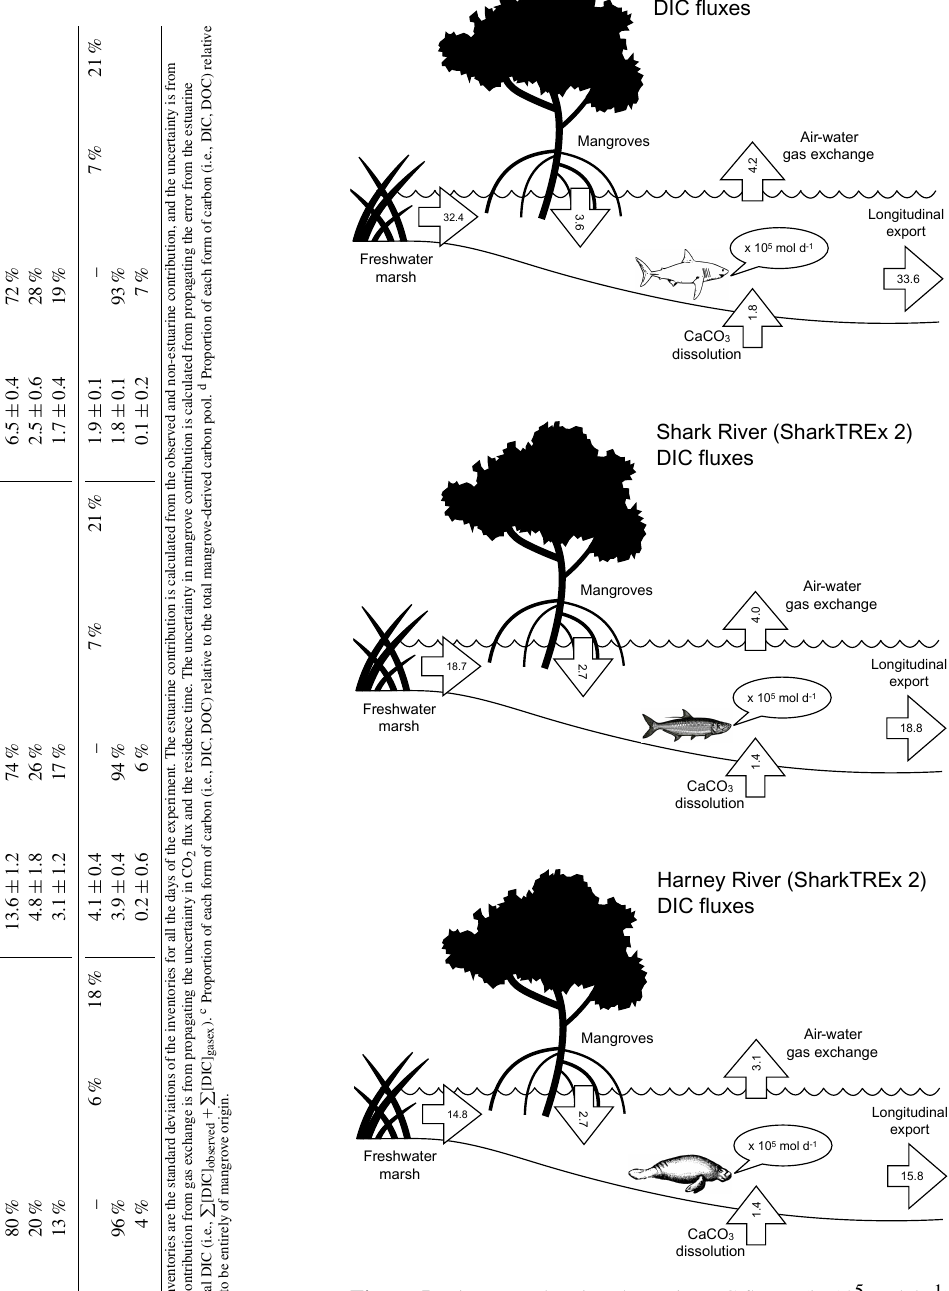
Figure 5. Diagrams showing the main DIC fluxes (in 10 5 mold − 1 ) entering and exiting the Shark and Harney rivers during SharkTREx 1 and 2. Fluxes from the freshwater marsh were assumed to be fluxes estimated from the conservative DIC curves.